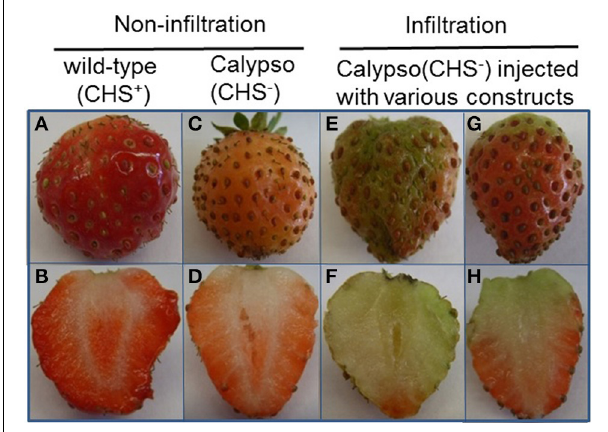
FIGURE 9 | Comparison of non-infiltrated and infiltrated Calypso (CHS − ) fruits. All pictures were taken 14 days after infiltration. Phenotypes of non-infiltrated (A–D) and infiltrated fruits (E–H) are compared. Non-infiltrated fruits of Calypso with CHS genes (CHS + ; A,B ) and Calypso with impaired CHS genes (CHS − ; C,D ) are shown. Infiltrated fruits (E–H) represent Calypso fruit (CHS − ) injected with Agrobacterium suspensions harboring either pBI-intron, FaCCR- , FaCAD- , FaPOD- ihpRNA, FaCCR- , FaCAD- , FaPOD- overexpression constructs, or combined pBI-Si3 and pBI-O3 constructs. All agroinfiltrated fruits showed a similar phenotype (E–H)